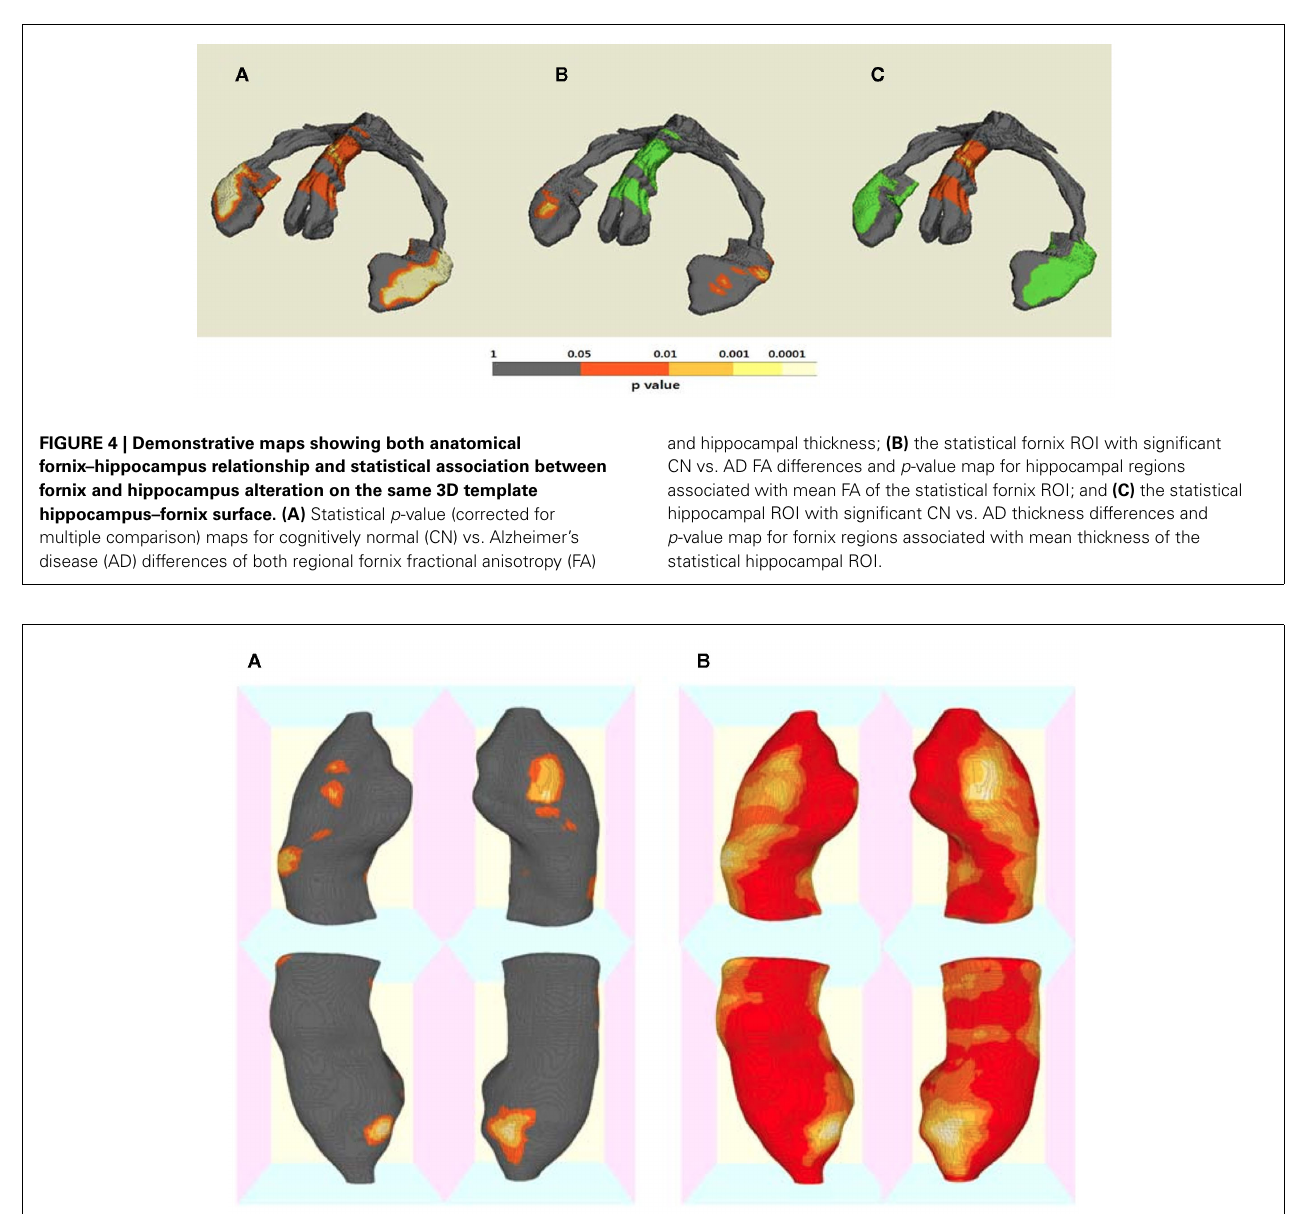
FIGURE 5 |Three-dimensional maps for the association of regional hippocampal atrophy with fornix microstructural alteration by Alzheimer’s disease (AD). (A) Statistical p -value (corrected for multiple comparisons) map and (B) R 2 map for the results of regression